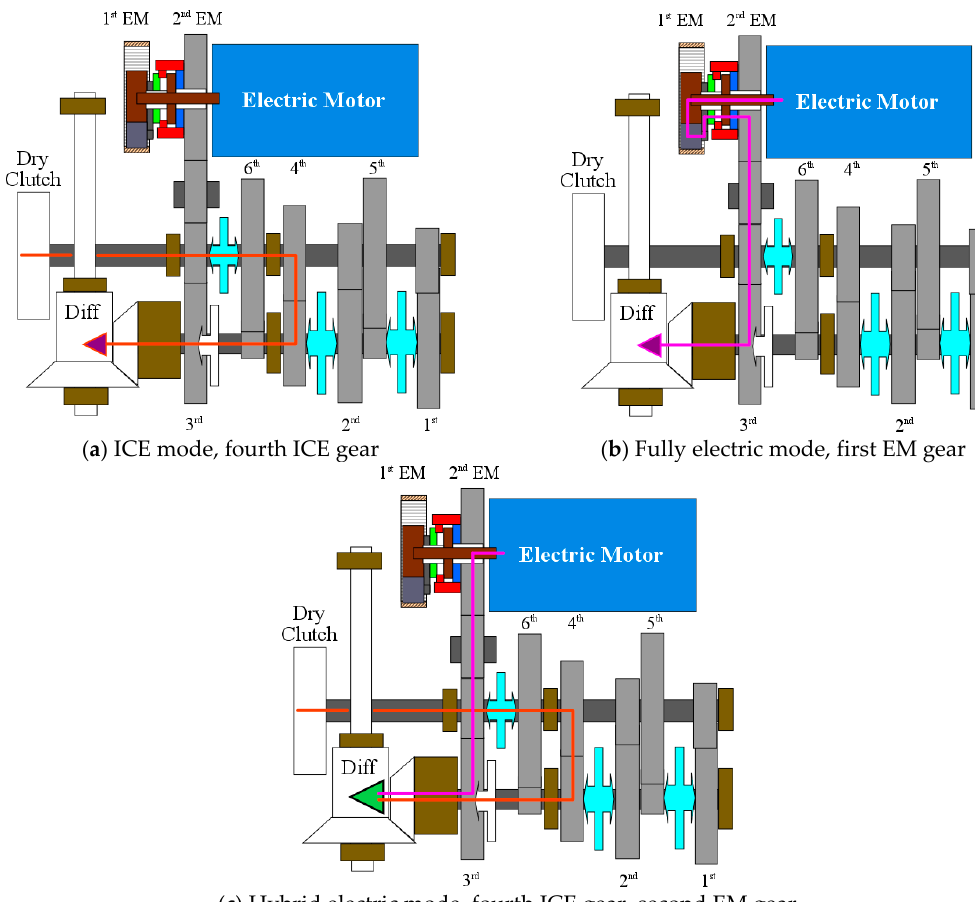
Figure 2. HAMT schematics in different modes with indication of the respective power flows in traction.